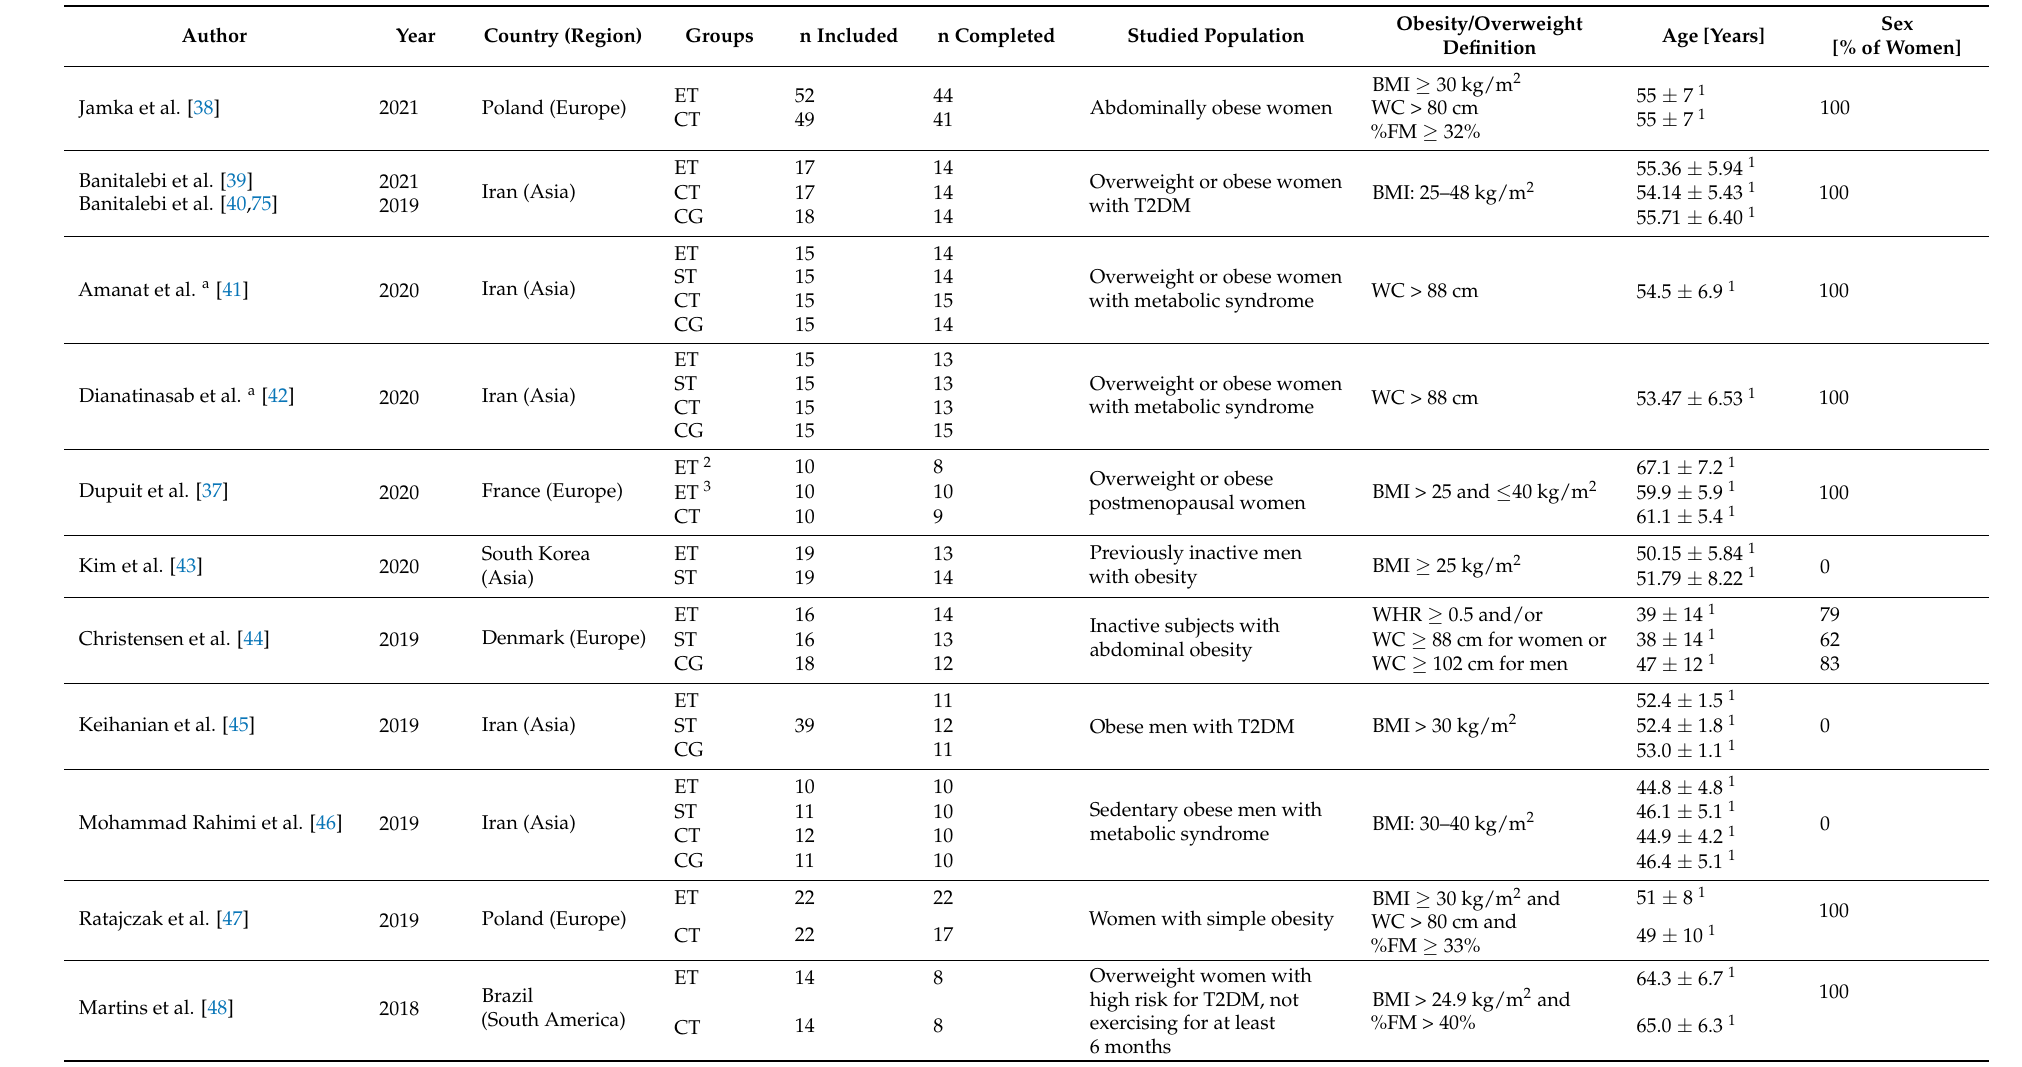
Table 1. Characteristics of included